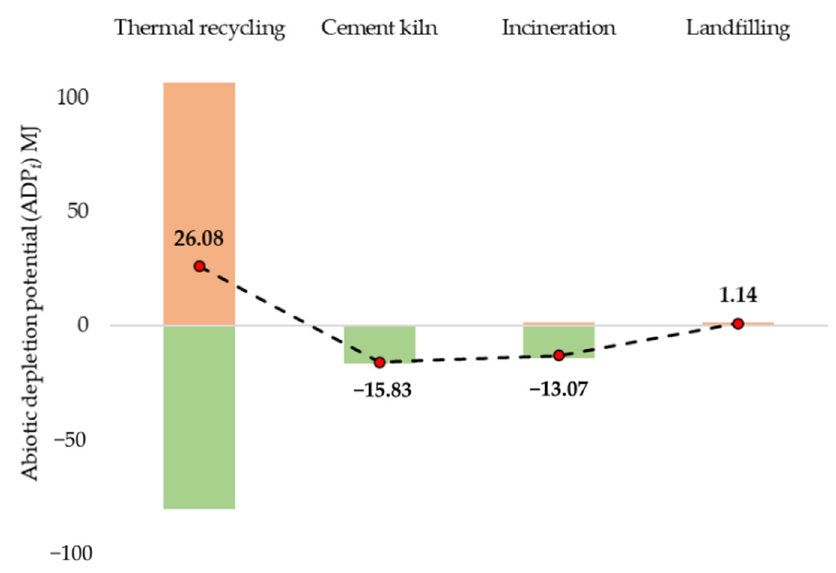
Figure 9. ADP f of various GFRP waste disposal scenarios.